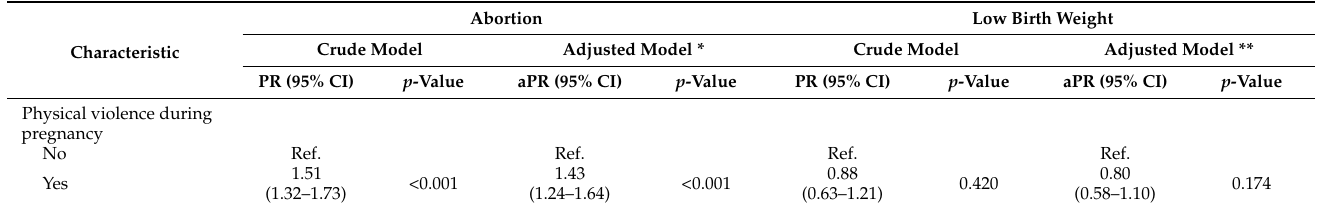
Table 4. Association between physical violence during pregnancy and birth outcomes, ENDES